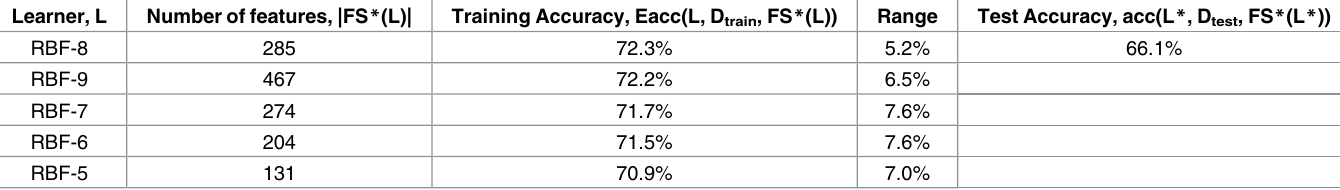
Table 7. ADHD-200,structural images.